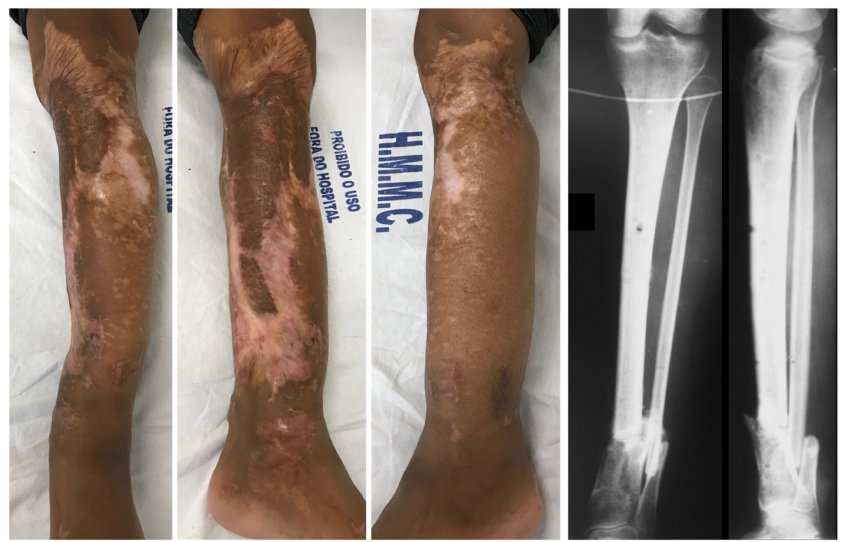
Figure 7. On day 100, the fracture and the leg wound were totally healed, and the patient was admitted for removal of the Ilizarov frame. Radiographs showed malunited fractures of the left distal tibia and fibula.